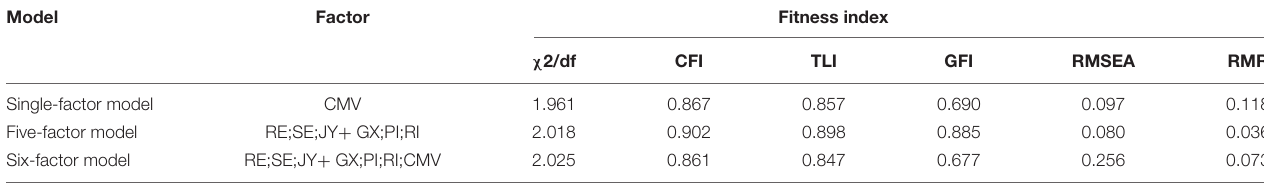
TABLE 4 | Common method bias test.